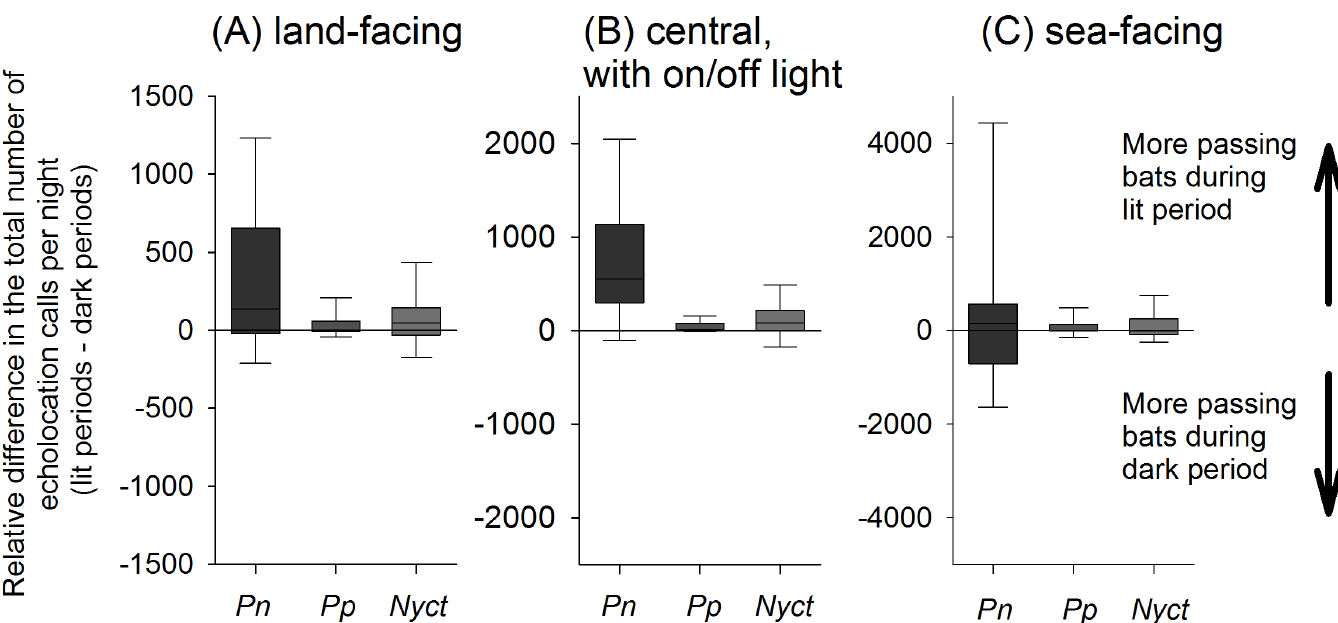
Fig 1. Difference in the cumulative number of echolocation calls recorded per night during the dark and light periods. Differences for P . nathusii (Pn), P . pygmaeus (Pp) and Nyctaloids (Nyct) at the landsidepole (A), the central pole with the light on-off treatment (B) and the seasidepole (C). Data are depictedas boxplotswith 25 and 75 percentiles as the border of the boxes and whiskers encompassing 5 and 95 percentiles.